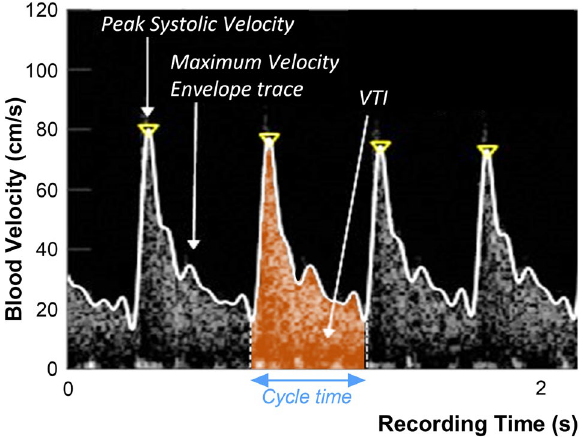
Figure 1. Metrics derived from the spectral Doppler signal for a single cardiac cycle. The velocity time integral (VTI) is the area under the maximum velocity envelope traced from the Doppler spectral waveform for a single cardiac cycle (highlighted in orange) bounded by the cycle time. VTI is also known as the stroke distance and is measured in